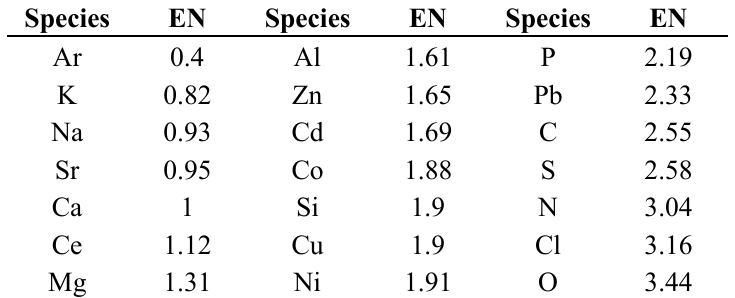
Table 3. Electronegativity of cerium (Pauling scale) compared to other common elements found in soils